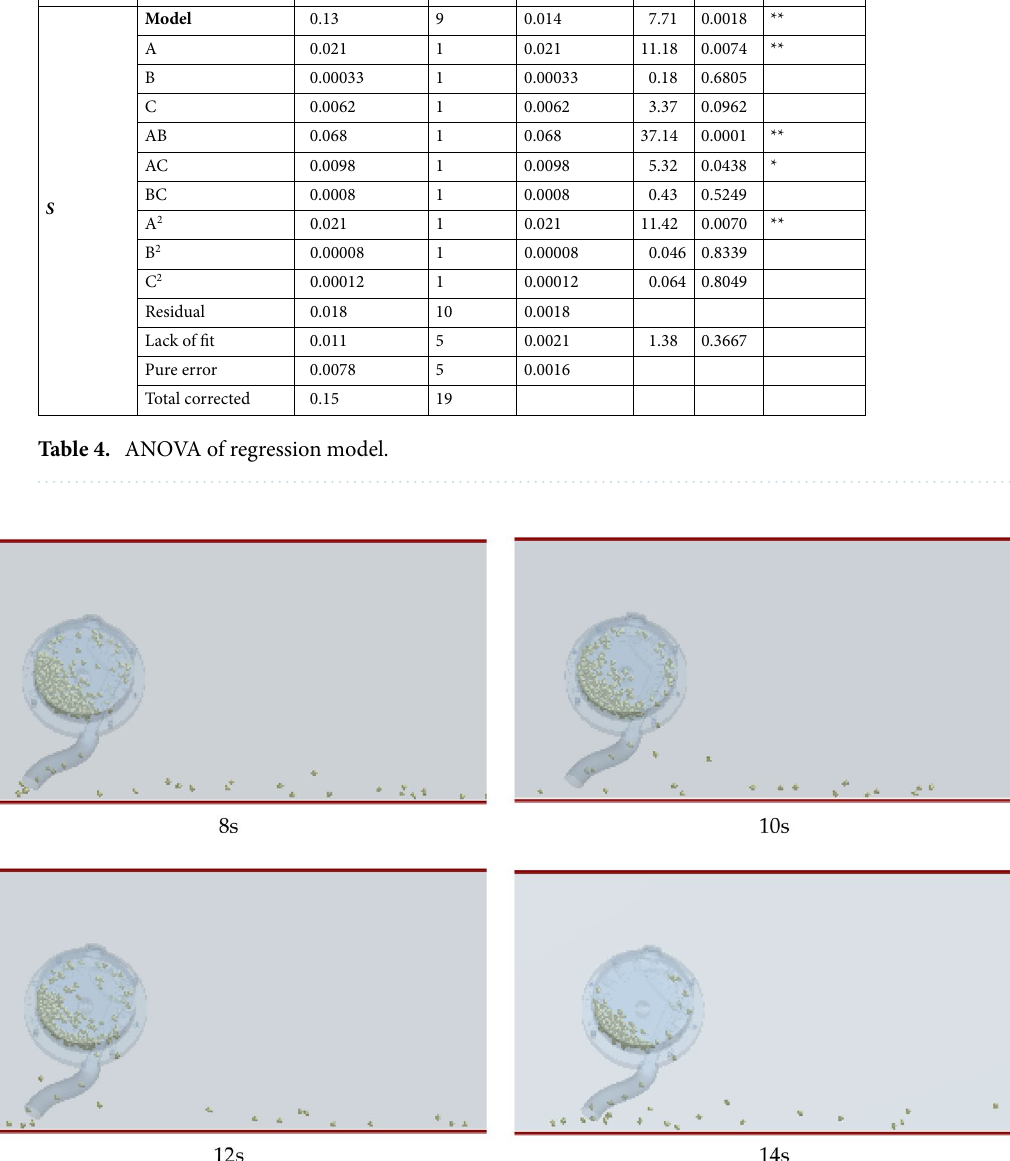
Figure 9. Variable seed motility behavior at various